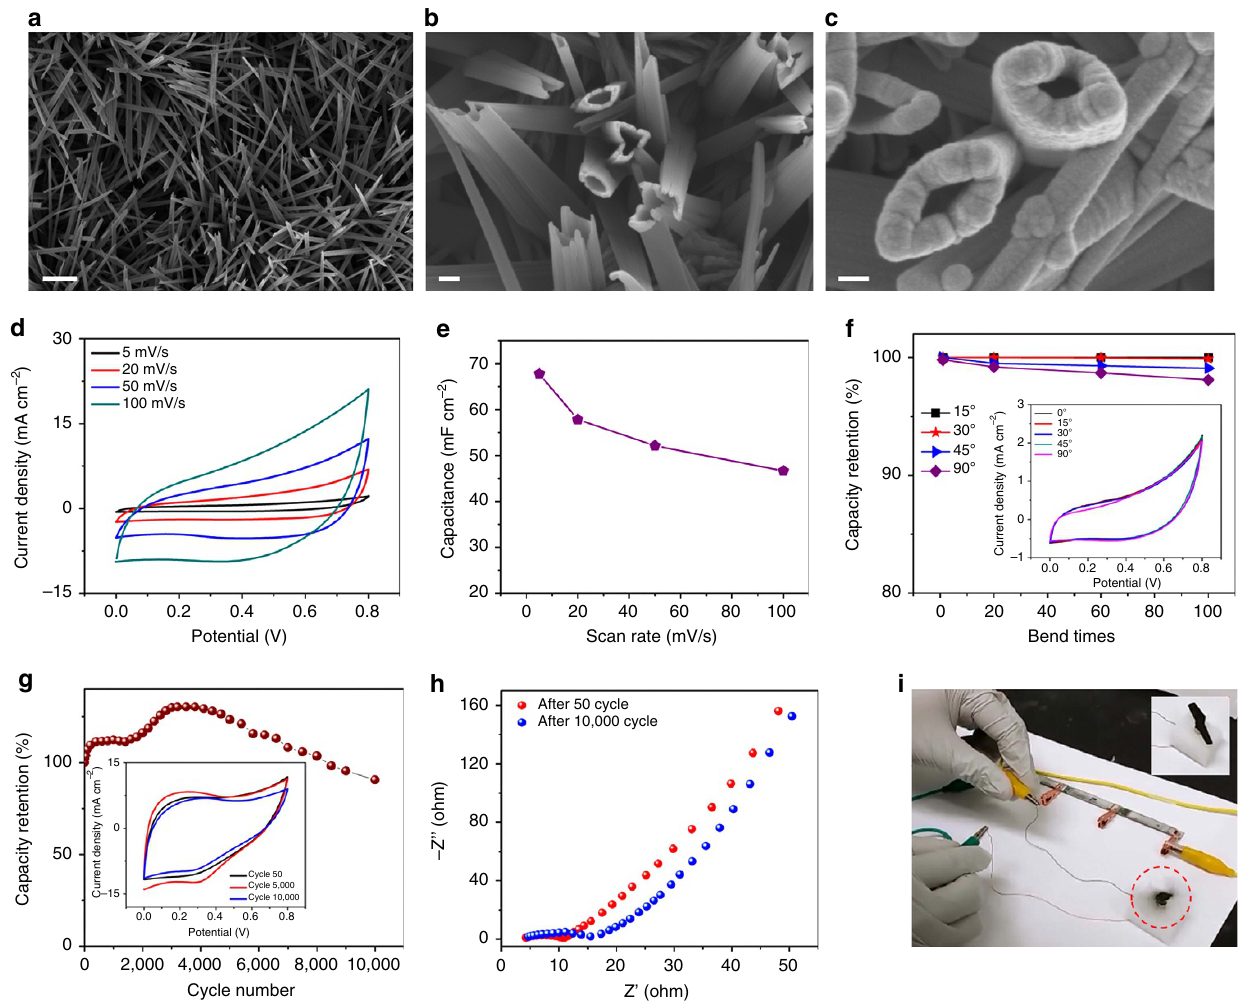
Figure 2 | Nanoarchitecture of electrode and electrical analysis of ENHANS device. ( a ) Low (scale bar, 2 m m)- and ( b ) high (scale bar, 200nm)- magnification FE-SEM images of CuOHNT represents the length ( B 8 m m) as well as diameter ( B 200nm) of the room temperature grown CuOHNT, ( c ) high-magnification FE-SEM image of MnO 2 -deposited tubular nanoarchitecture (scale bar, 80nm), ( d ) CV profile of the device at different scan rates, ( e ) cell capacitance calculated from the CVcurves, ( f ) capacitance of the device at different bending angles (inset shows the CVcurves at various bending angle), ( g ) cycle life study to explore the continuous electrochemical effect on the stability of the MnO 2 -deposited nanotubes (inset represents the CV curve of the device at certain cycle numbers), ( h ) Nyquist plot obtained from the EIS study of the as-prepared device and ( i ) rotating a propeller of toy drone with three charged supercapacitors in series. Inset is the picture of the propeller before connecting to the